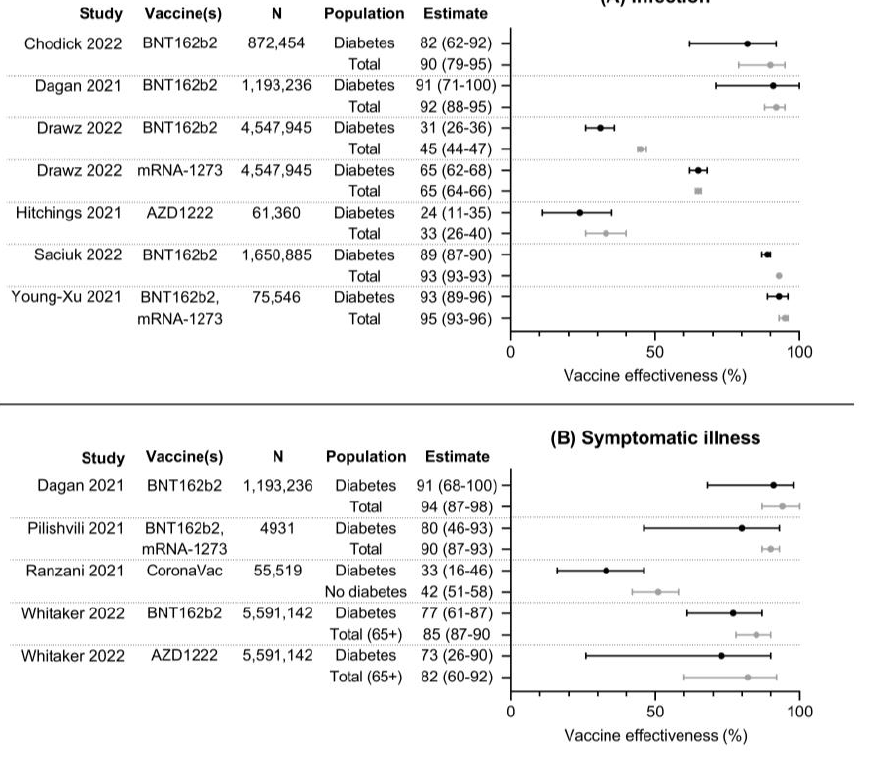
Figure 2. Forest plots with point estimates and 95% confidence intervals of effectiveness of COVID-19 vaccines against ( A ) infection, ( B ) symptomatic illness, ( C ) hospitalization, and ( D ) death. N denotes total number of participants per study, as numbers per group were usually not available [20,22,23,25–27,29,31–35].